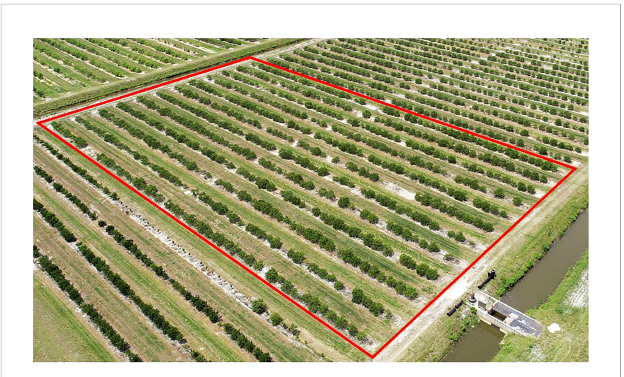
FIGURE 1 Aerial image of the Picos 2014 rootstock trial in